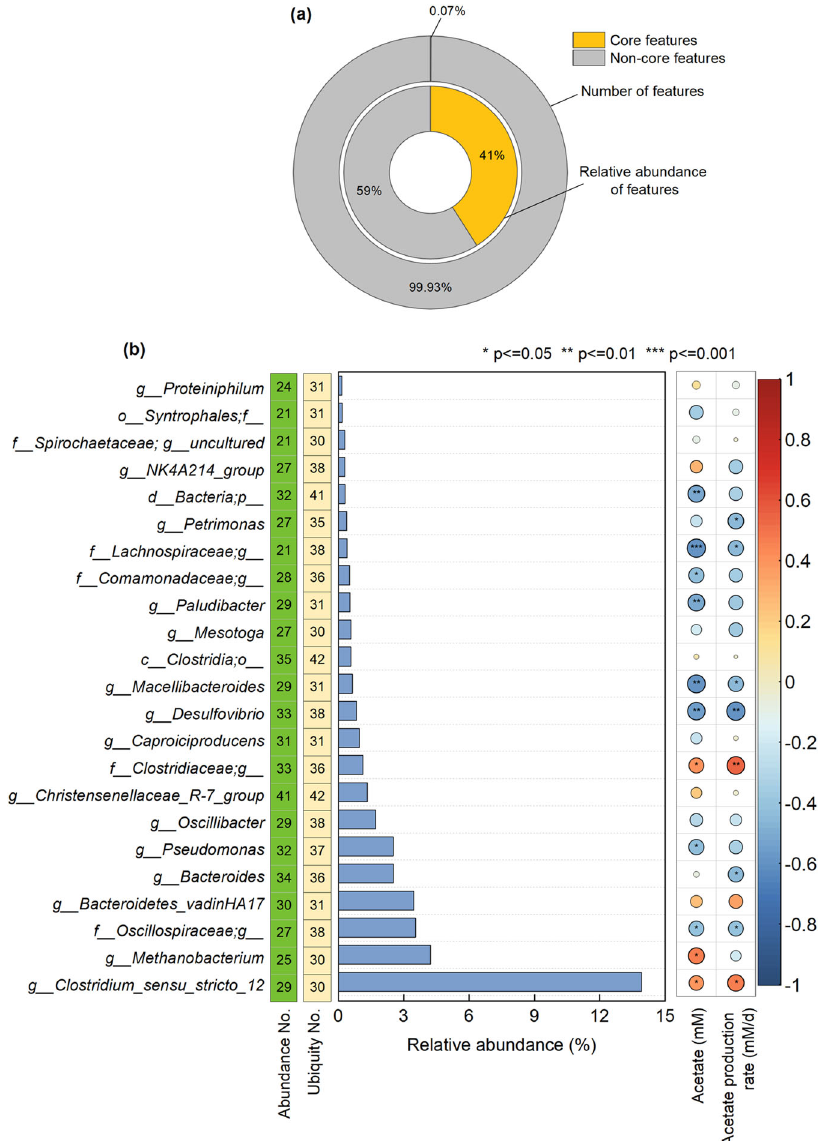
Fig. 1 Characterizations of core features identi fi ed. a Percentage and relative abundance of the core features and b the taxonomic composition of core features at the genus level and their frequency of abundance (green column), frequency of ubiquity (yellow column), and correlation with acetogenic